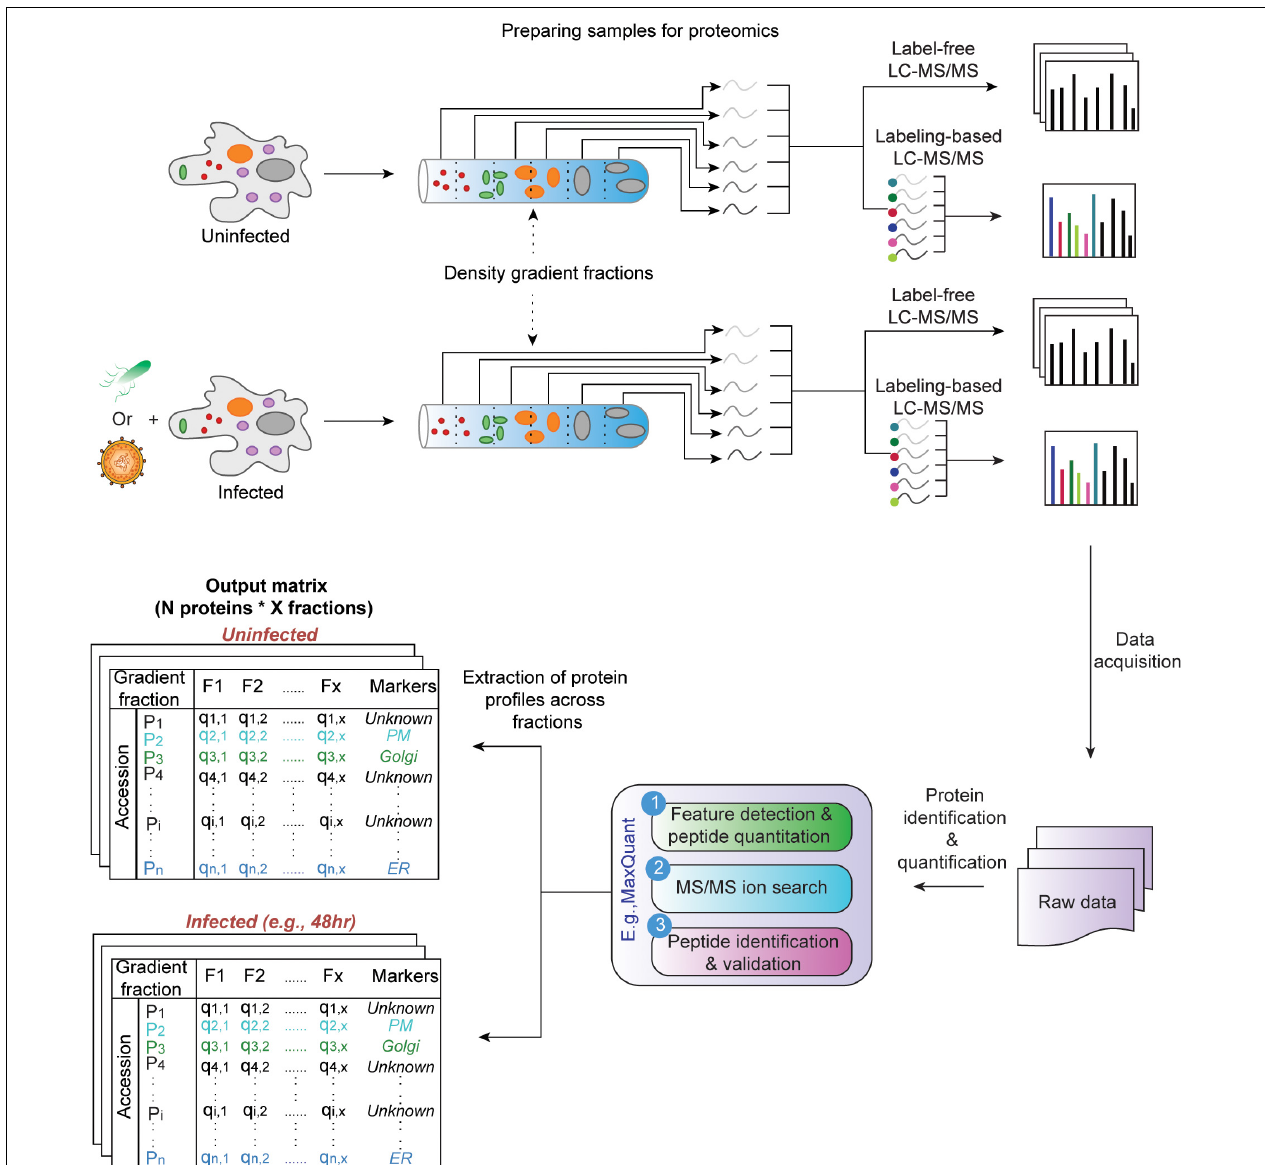
FIGURE 6 | Schematic overview of gradient fractionation-based spatial proteomics. Infected and uninfected cells are lysed, and lysates are fractionated (Borner, 2020). The resulting fractions are then analyzed by label-free or multiplexed label-based quantitative MS. Proteins are then identified and quantified using specialized software (e.g., MaxQuant). This generates a data matrix containing relative protein abundances across fractions for N proteins along X fractions for infected and uninfected samples. Additional metadata (e.g., manually curated organelle markers) are added to the matrix to facilitate subsequent analyses. “Unknown” in the “marker” column indicates non-marker proteins with unknown